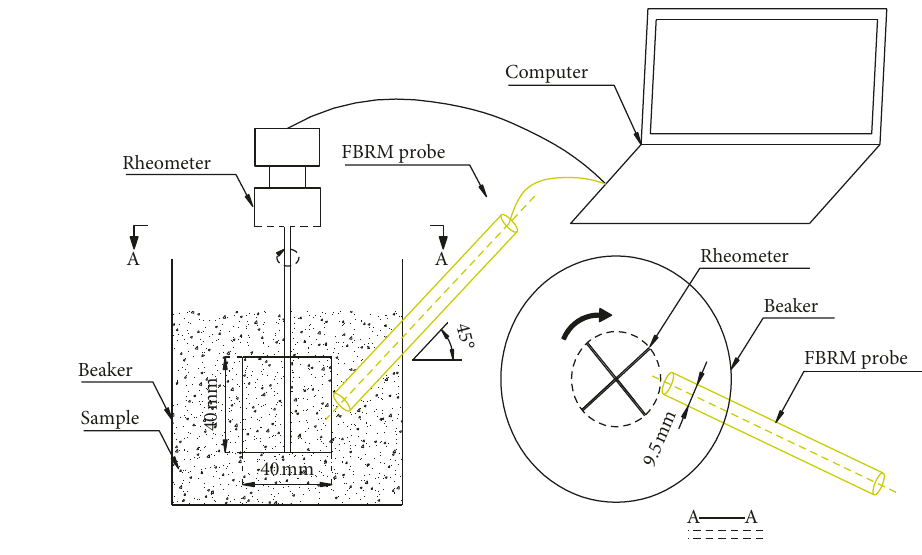
Figure 4: Experimental equipment. Table 4: Herschel–Bulkley model parameters for